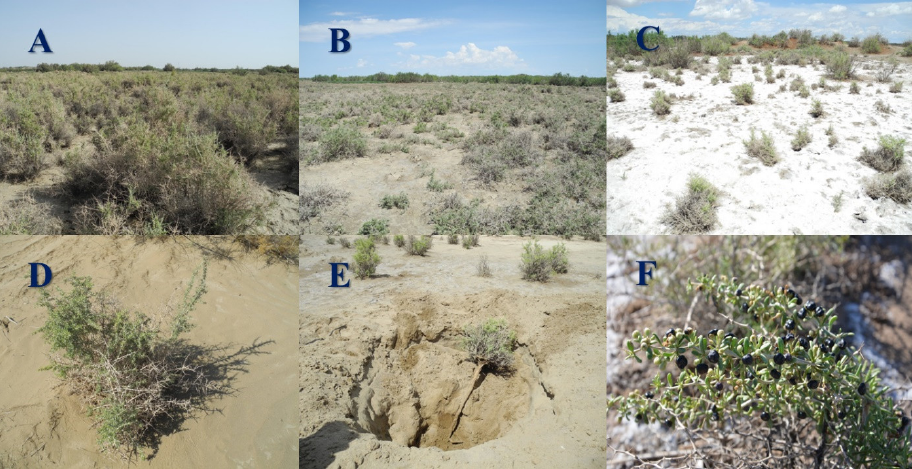
Table 1. Site characteristics for eight Lycium ruthenicum populations in the lower reaches of Heihe River (Mean ± SD, n = 3).